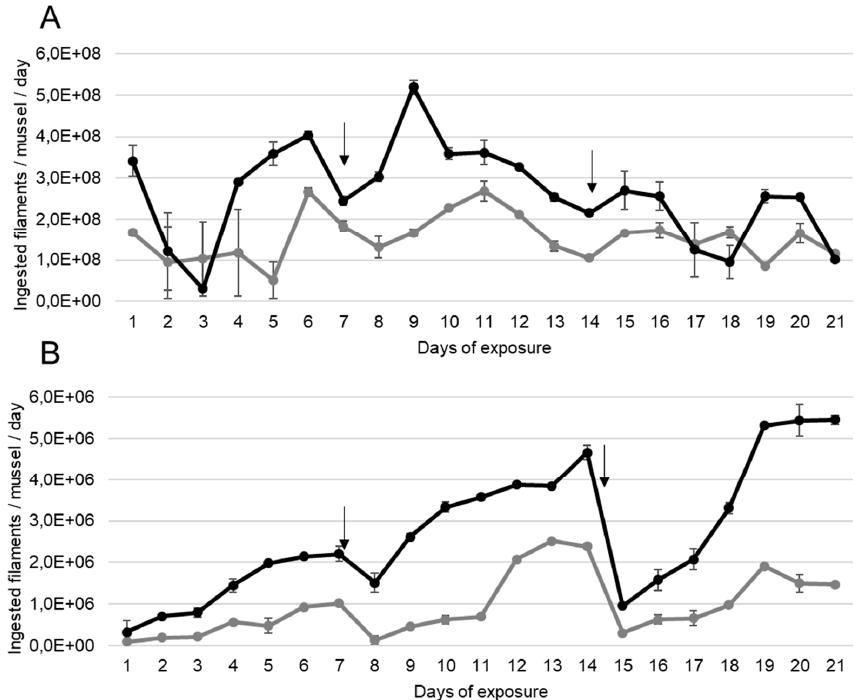
Figure 1. Mean ± S.E.M number of filaments of P. agardhii ingested per day by ( A ) A. anatina and ( B ) D. polymorpha , during exposure to a density of filaments producing an equivalent of 10 µ g (grey lines) and 100 µ g (black lines) MC / L, n = 2 aquariums. Days for which the water was completely renewed are indicated with an